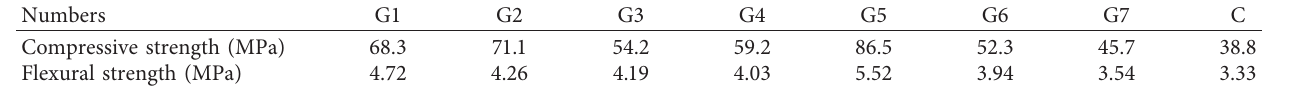
Table 8: Compressive strength and flexural strength of each specimen cured at 60 ° C for 7 days.